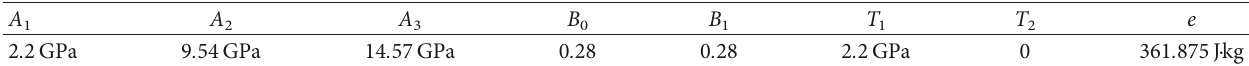
Table 2: The parameters of polynomial EOS for water [25,